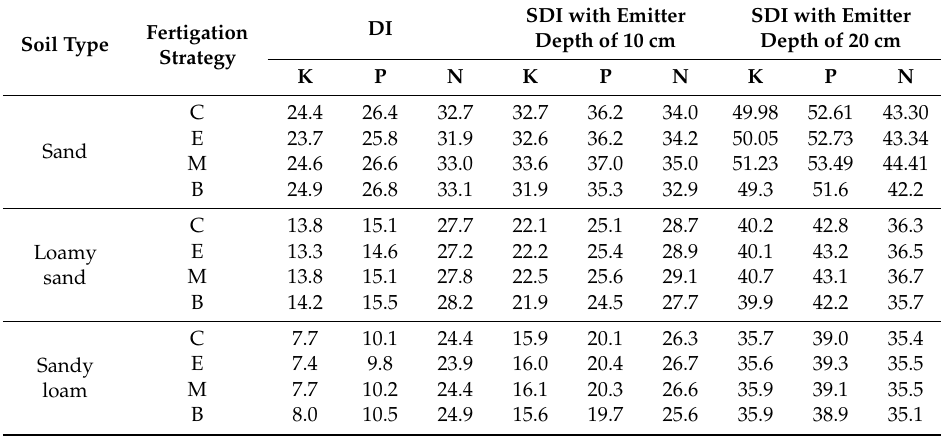
Table 5. Percentage of potassium, phosphorus, and nitrogen accumulated below the maximum root density zone as a fraction of the total potassium, phosphorus, and nitrogen added,